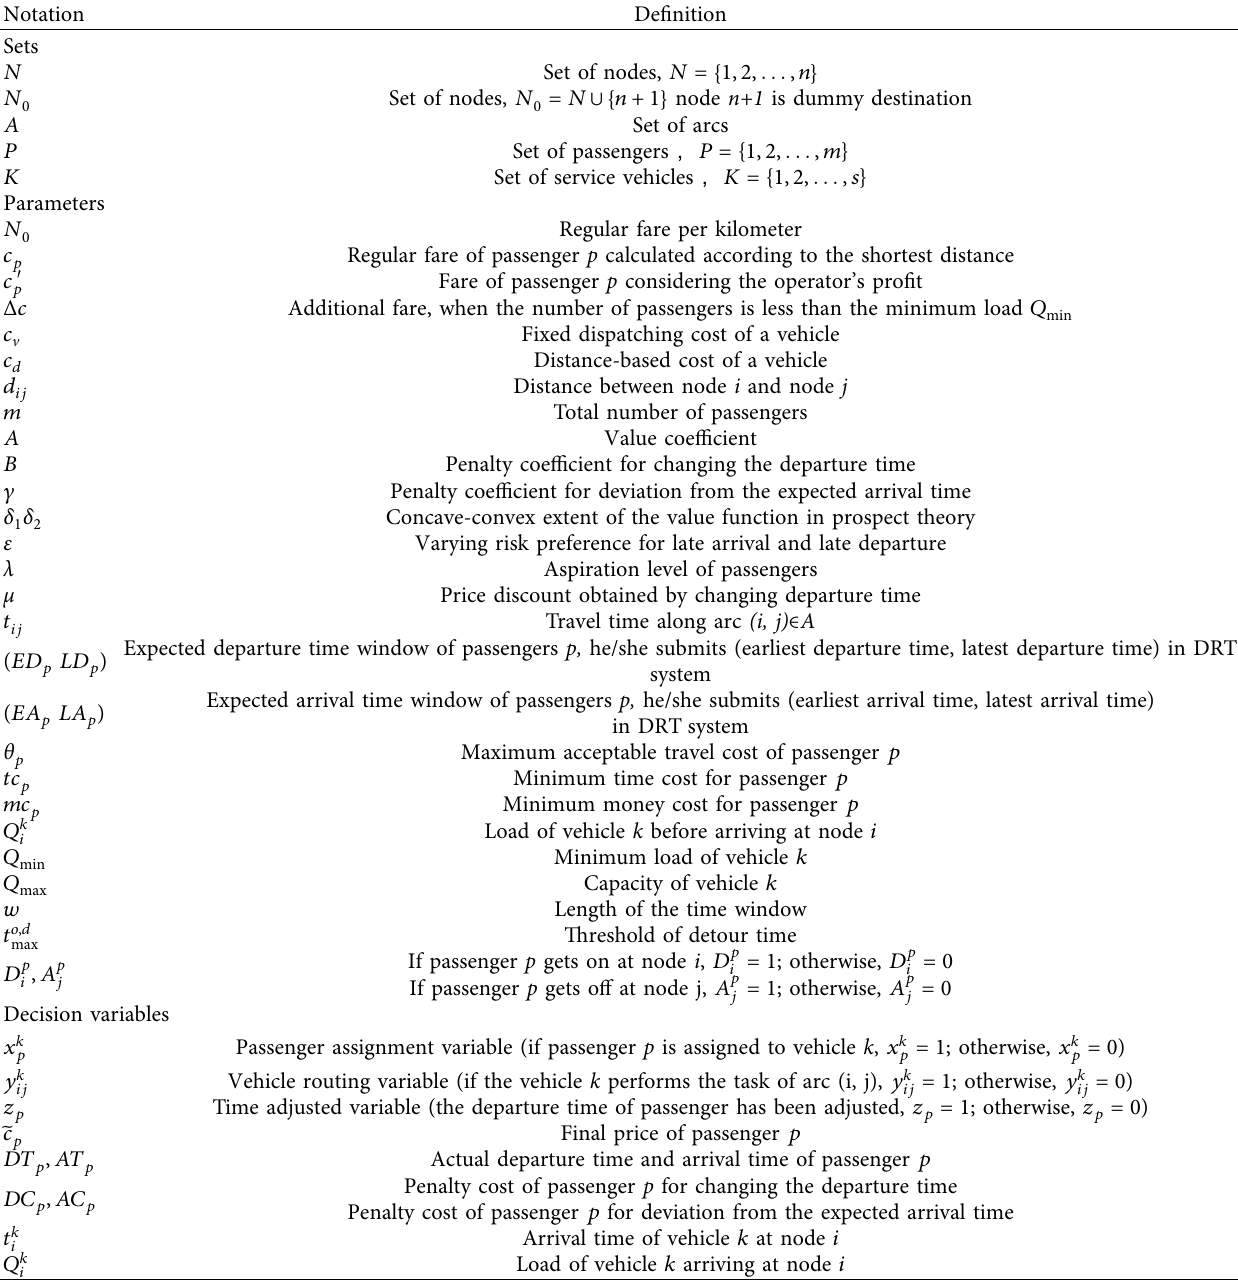
Table 2: Notation for the sets, parameters, and decision